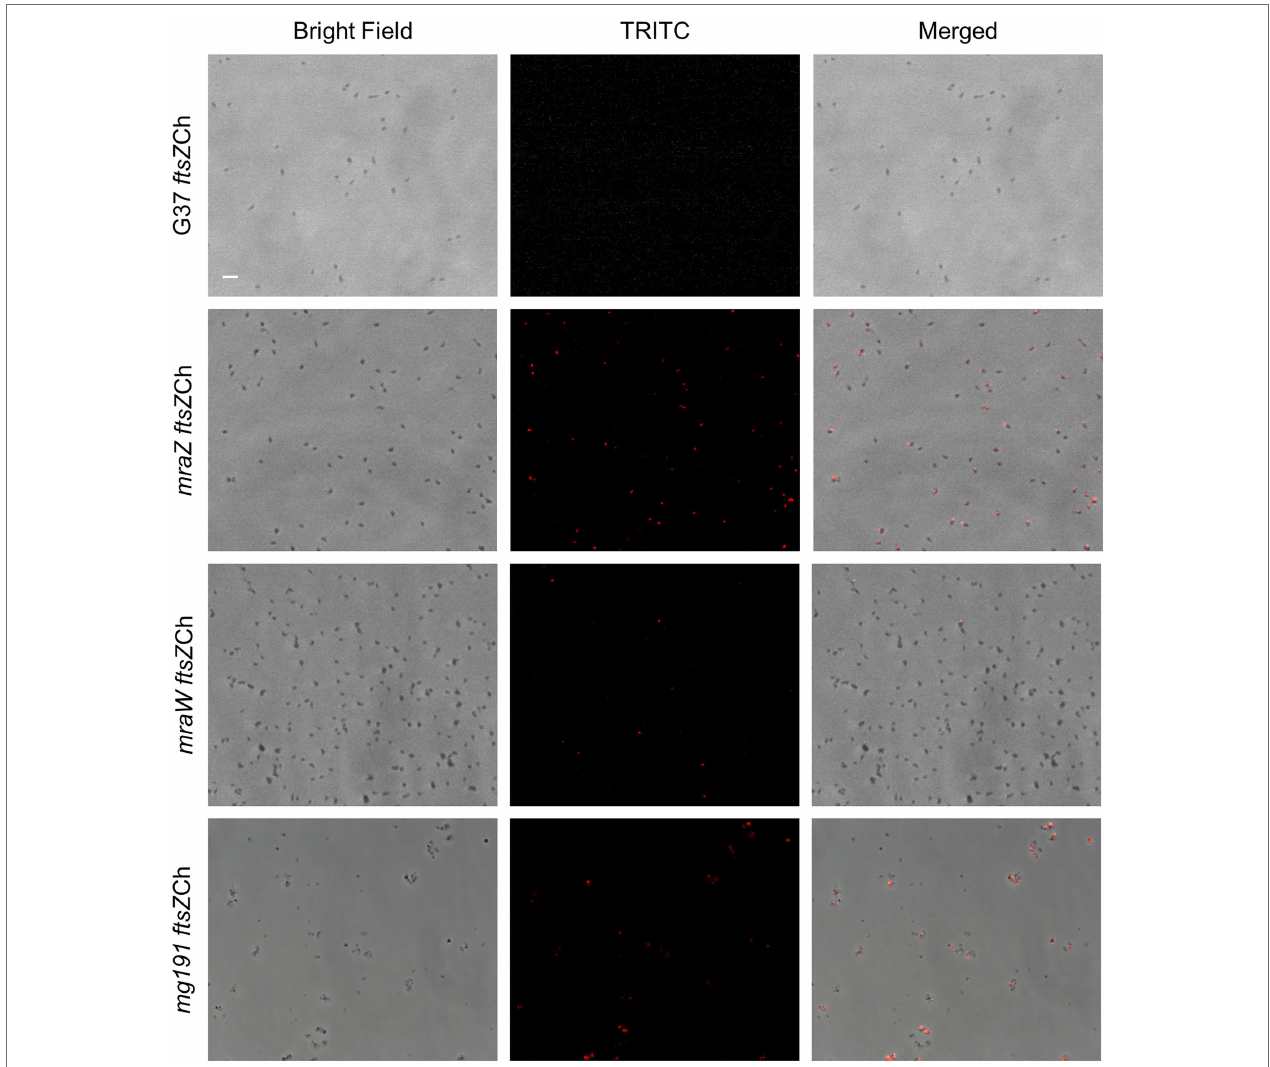
FIGURE 5 | Single cell analysis of FtsZ expression in different M. genitalium mutants. Fluorescence microscopy images showing FtsZ-mCherry localization in live cells from the wild-type strain, mraZ , mraW , and mg191 mutants. Each row contains the phase contrast, TRITC channel, and the resulting overlay, respectively. The scale bar represents 2 μ m. All images are shown at the same